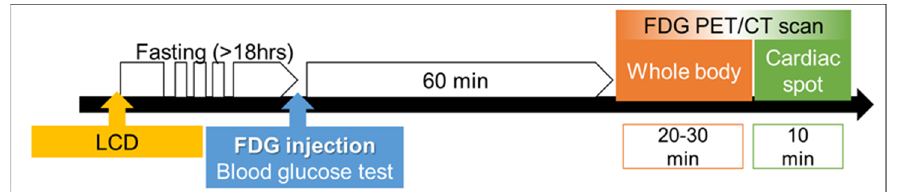
Figure 2. Typical time schedule of the FDG-PET/CT scan. Preparations before FDG-PET/CT include a low-carbohydrate diet (LCD) and prolonged fasting (over 18 h). Delayed cardiac spot imaging is also recommended if the time schedule permits